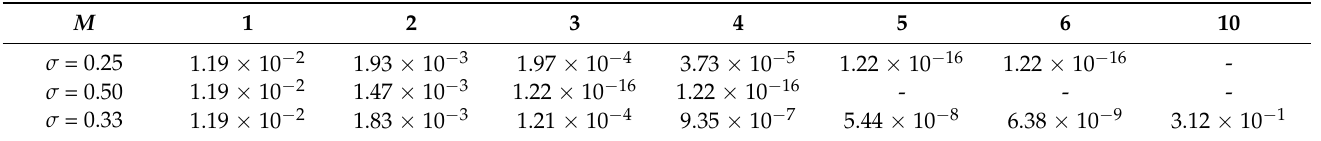
Table 1. The MAE versus the M at t = 1 for different σ